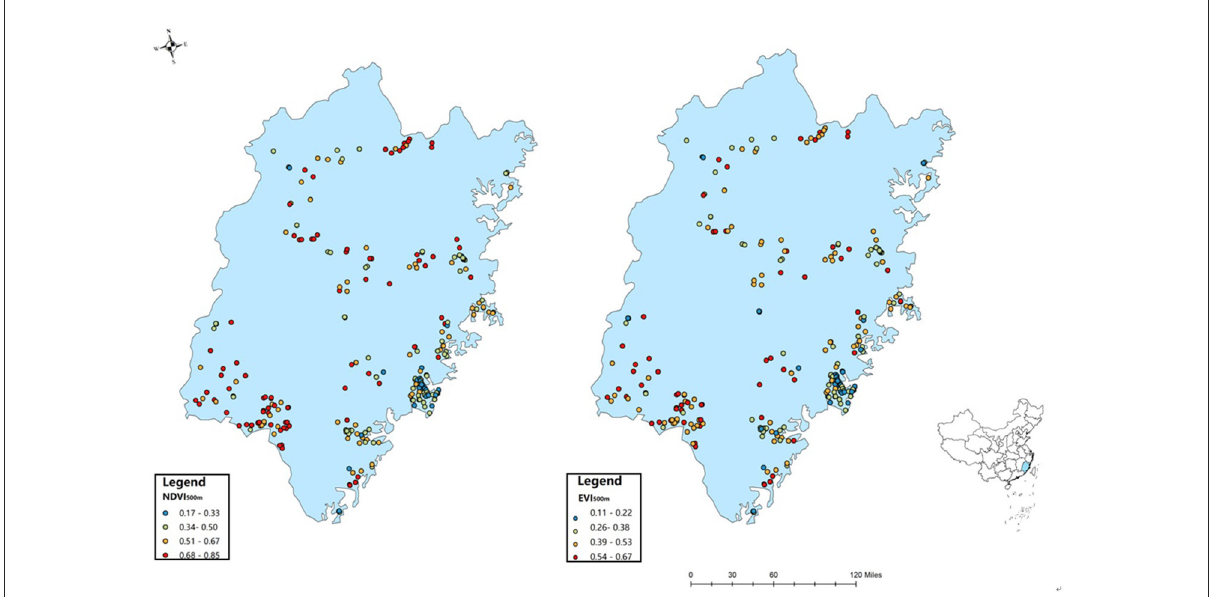
FIGURE1 Residential greenness exposure and location of the study area on the map of China. NDI, normalized difference vegetation index; EVI, enhanced vegetation index.